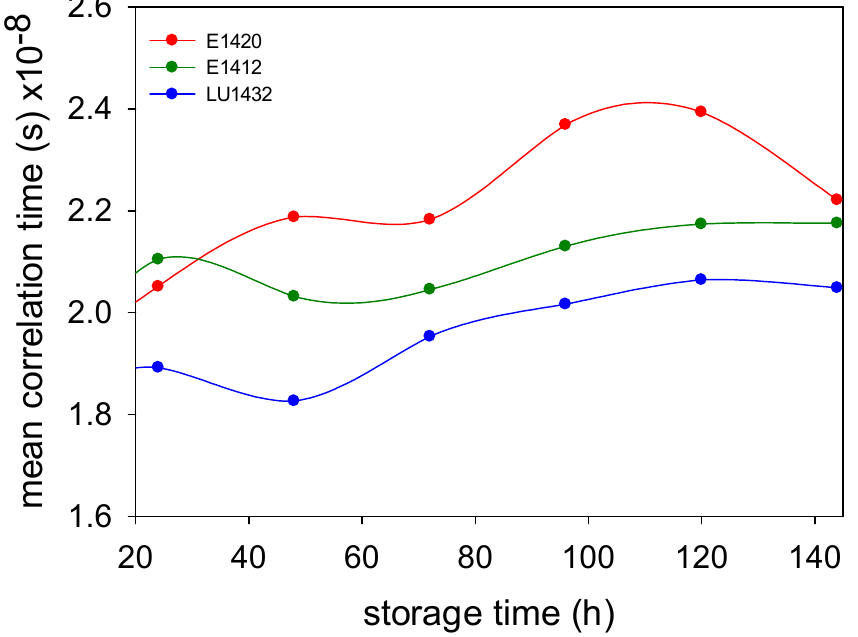
Figure 3. Long-term changes in mean values of proton motion correlation times in potato starch gels.